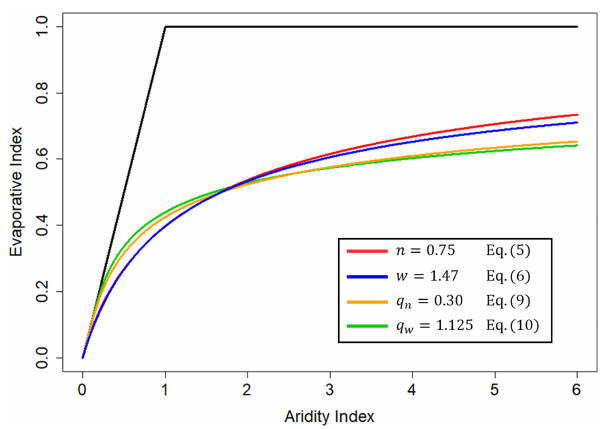
Figure 5. Illustration of the contradiction between different ver- sions of the four parametric Budyko equations. Constant parameter trajectories, defined by each of the four parametric equations, cross one another. This means that if a catchment has a constant parame- ter trajectory in one formulation, the parameter must change for the other